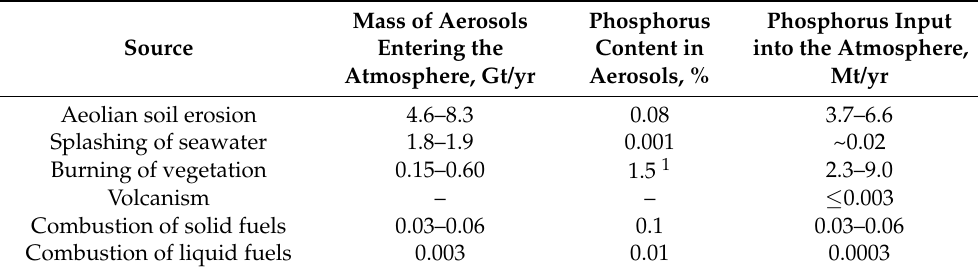
Table 1. Sources of phosphorus in the atmosphere